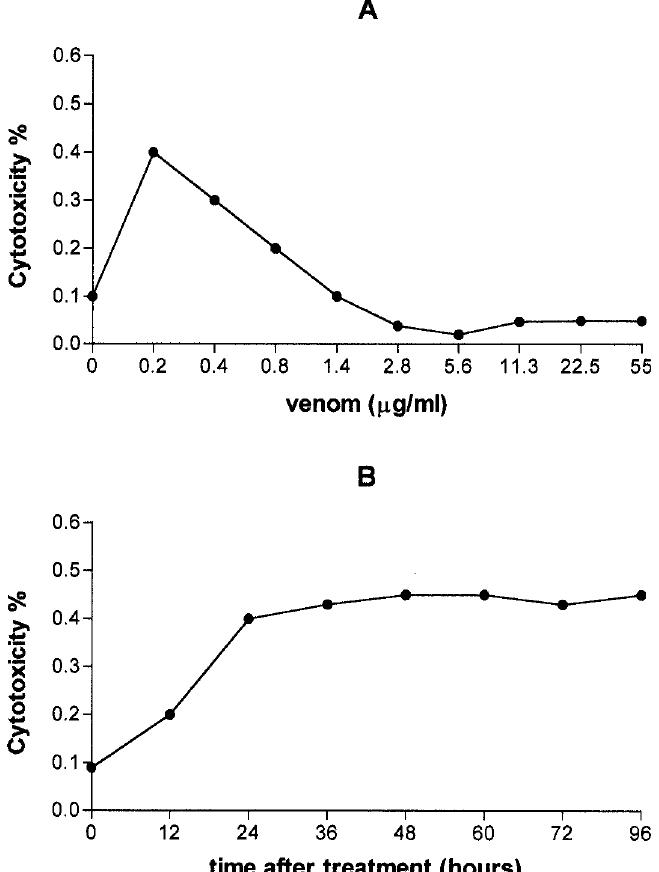
FIG. 1. Effect of TSV on macrophage cytotoxicity and viability. Groups of BALB/c mice were sacrificed and their peritoneal macrophages collected and stimulated in vitro with different amounts of TSV. (A) After different times of incubation of the cultured peritoneal macrophages, the cytotoxicity percentages were determined. (B) For the kinetics of the effect of TSV on cytotoxicity, the macrophages were obtained from mice and in vitro stimulated with 0.2 m g/ml of TSV. Each point represents the mean ± standard deviation value of samples from five experiments in different groups of five